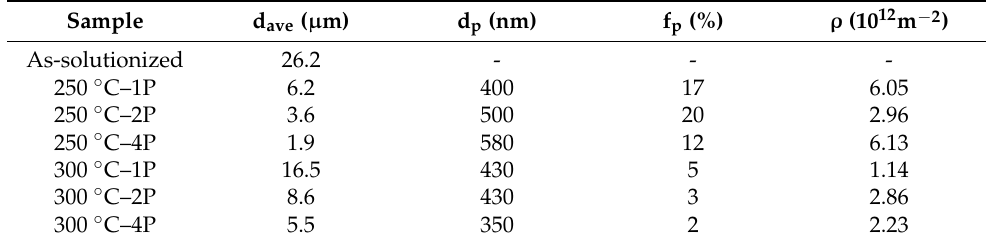
Table 1. Microstructure characteristics of the ECAP